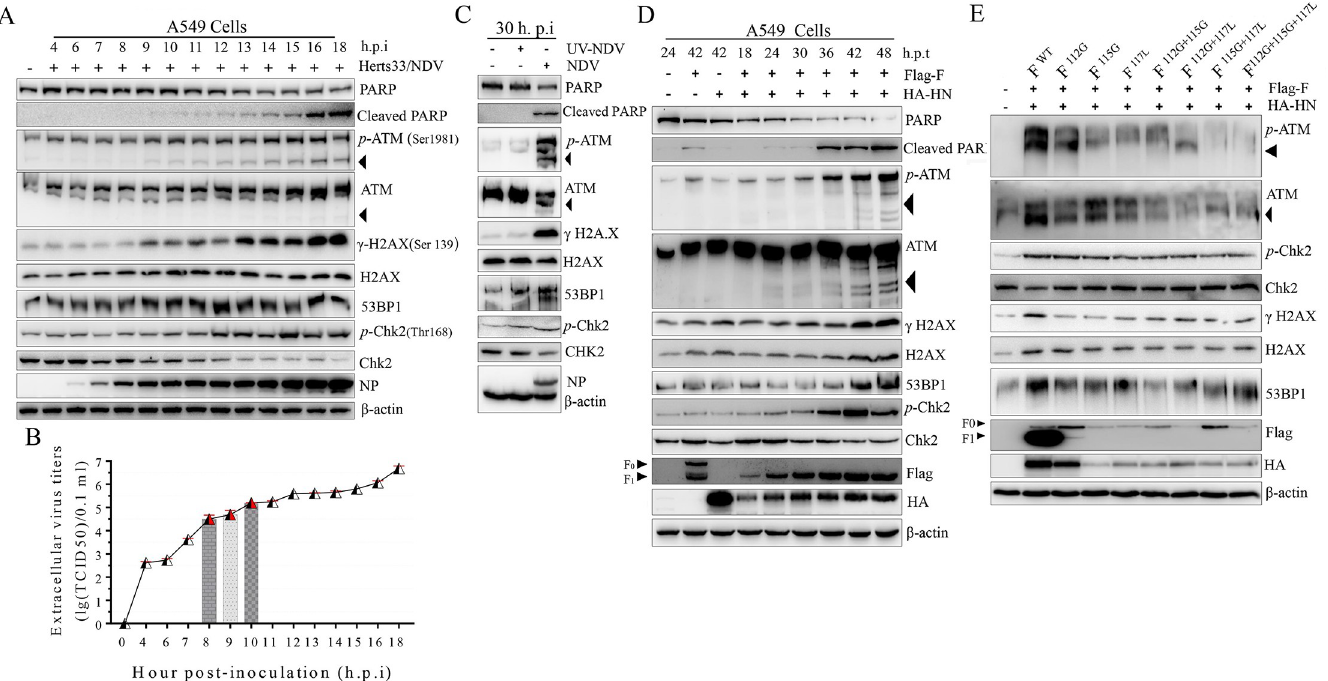
Fig 2. NDV late replication and membrane fusion induced DNA double strand break (DSB) through ATM kinase activation. (A) Virulent oncolytic NDV infection activated ATM-mediated DSB signaling in A549 cells. Western blot samples were prepared from A549 cells after virulent oncolytic NDV infection (Herts/33 strain) (MOI = 1) corresponding to the marked timepoints and analyzed in accordance with the procedures in the Materials and Methods section. The monomer ATM was marked with a black triangle. β -actin served as a loading control. (B) Growth curve of extracellular NDV in A549 cells. The extracellular NDV titers of culture supernatant were determined on DF-1 cells as TCID 50 based on the Reed–Muench method. Error bars are indicated by red dashed lines. (C) NDV replication was required for ATM-mediated DSB signaling pathway activation. A549 cells were infected with virulent oncolytic NDV (Herts33/NDV strain) (MOI = 1) and UV- inactivated NDV. At 30 h.p.i., Western blot samples were collected and analyzed in accordance with the procedures in the Materials and Methods section. The monomer ATM was marked with a black triangle. (D) F and HN cooperated synergistically to activate ATM-mediated DSB in A549 cells. A549 cells were transfected with plasmids Flag-F, HA-HN, or both. Western blot samples corresponding to the marked timepoints were collected and analyzed in accordance with the procedures in the Materials and Methods section. (E) The cleavage site motif of F influenced the ATM-mediated DSB signaling pathway. In A549 cells, wild-type HN plasmids were co-transfected with wild-type F, F 112G , F 115G , F 117L , F 112G+115G , F 112G+117L , F 115G+117L , and F 112G+115G+117L . At 36 h.p.t., the corresponding Western blot samples were collected and